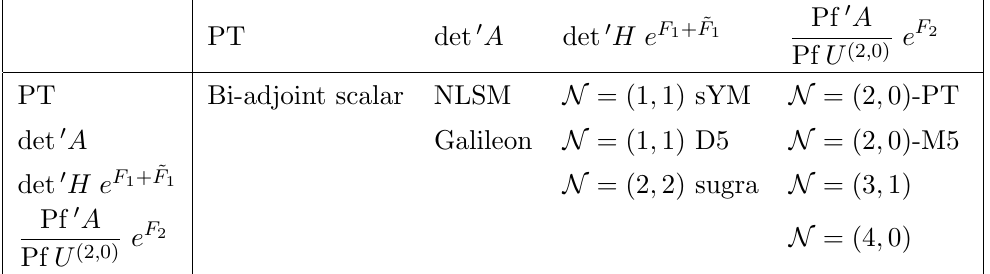
Table 1 . All integrands constructed from the building blocks discussed